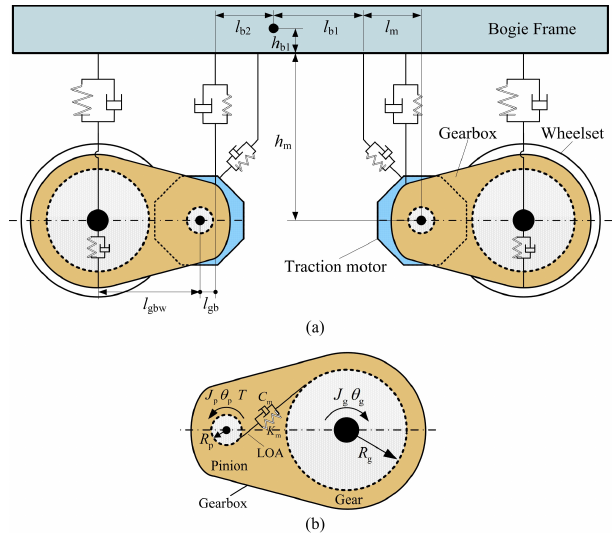
Figure 2. Traction and transmission system of a metro vehicle. Schematic representation of (a) the drive system and (b) the gear- box and transmission